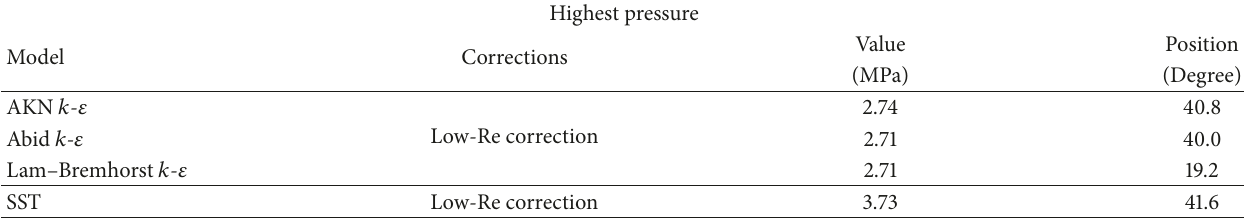
Table 9: Highest pressure of the turbulence models with low-Re correction